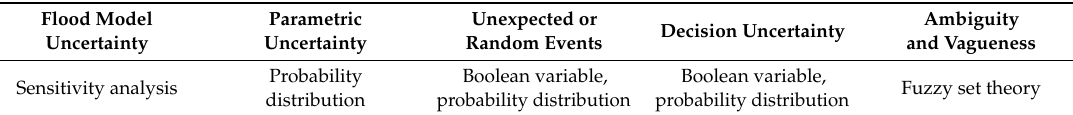
Table 2. Mathematical characterization of